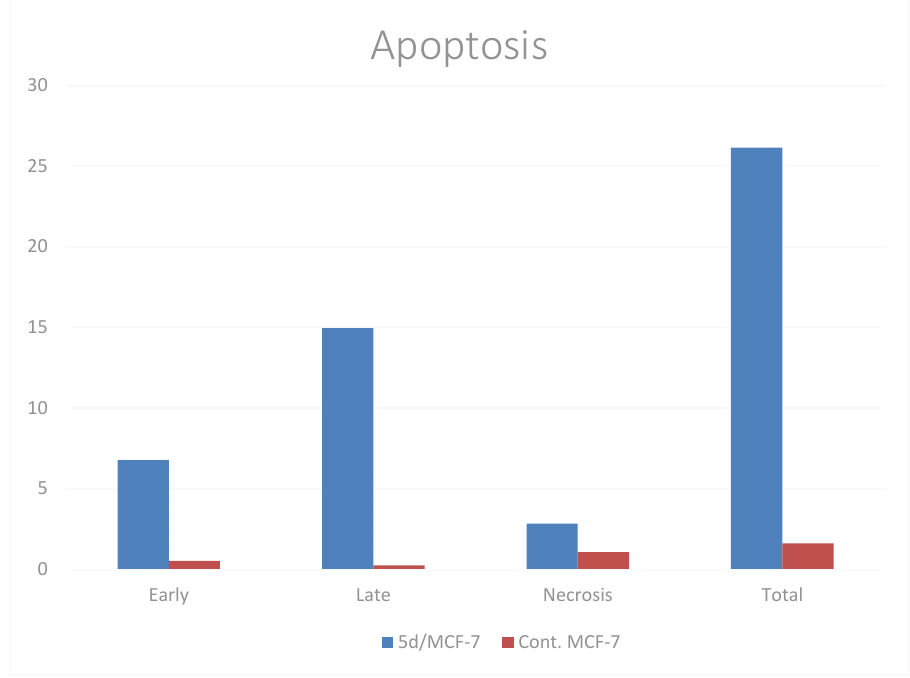
Figure 5. Induction of apoptosis of MCF-7 cells after treatment with compound 5d .